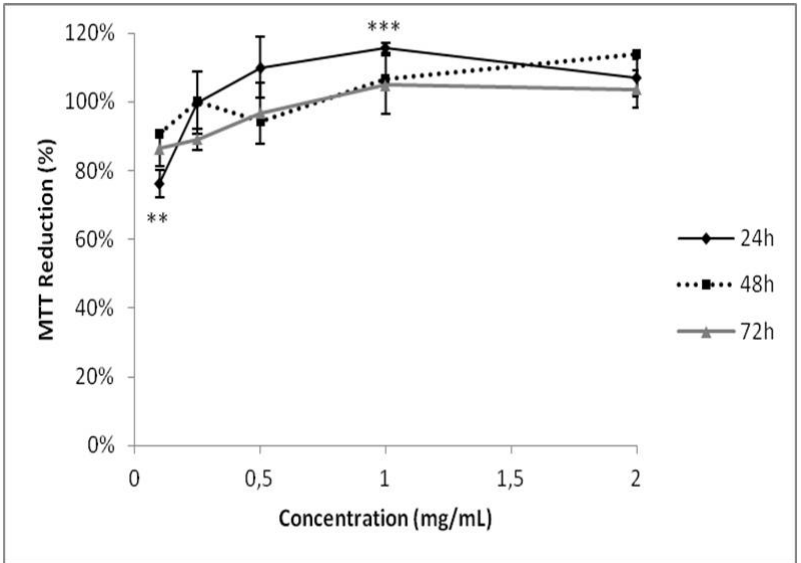
Figure 6. Evaluation of GB toxicity on HEK-293 cell viability. The cells were grown in a range of GB concentrations (0.125–2.000 mg/mL) for 24, 48, or 72 h. Cell viability was measured using the MTT test. ** ( p < 0.05) and *** ( p < 0.001) indicate significant differences between the concentrations obtained using one-way ANOVA, followed by the Student-Newman-Keuls test.